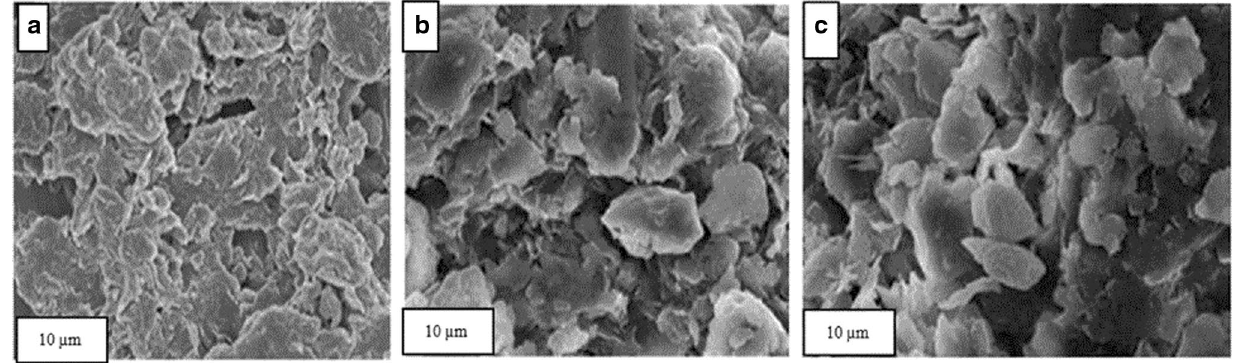
Fig. 5 SEM images of Arg-Na ( a ), Arg-HDTMA ( b ) and Arg-HDPy ( c